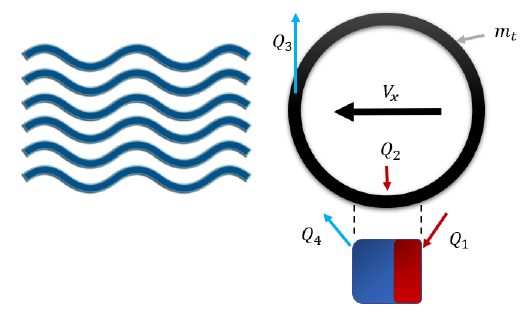
Figure 4. Considered heat flows in the thermal